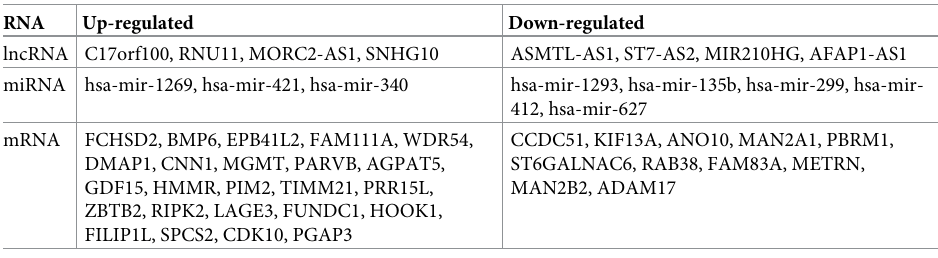
Table 1. The prognostic mRNAs, miRNAs and